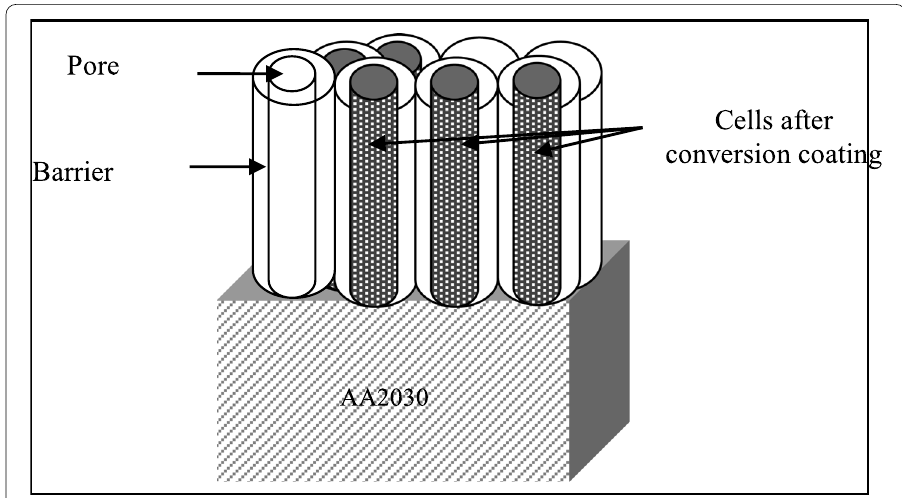
Fig. 5 Schematic diagrams showing the structure of aluminum layer after anodizing treatment and conversion